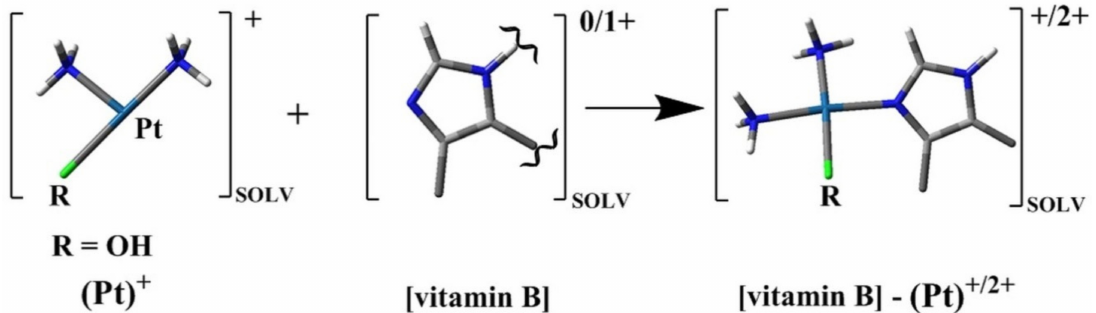
Figure 6. Scheme of complexes of B vitamins with Pt(NH 3 ) 2 (OH) + of carboplatin. The only vitamin with a positive charge is Thiamine (vitamin B1).